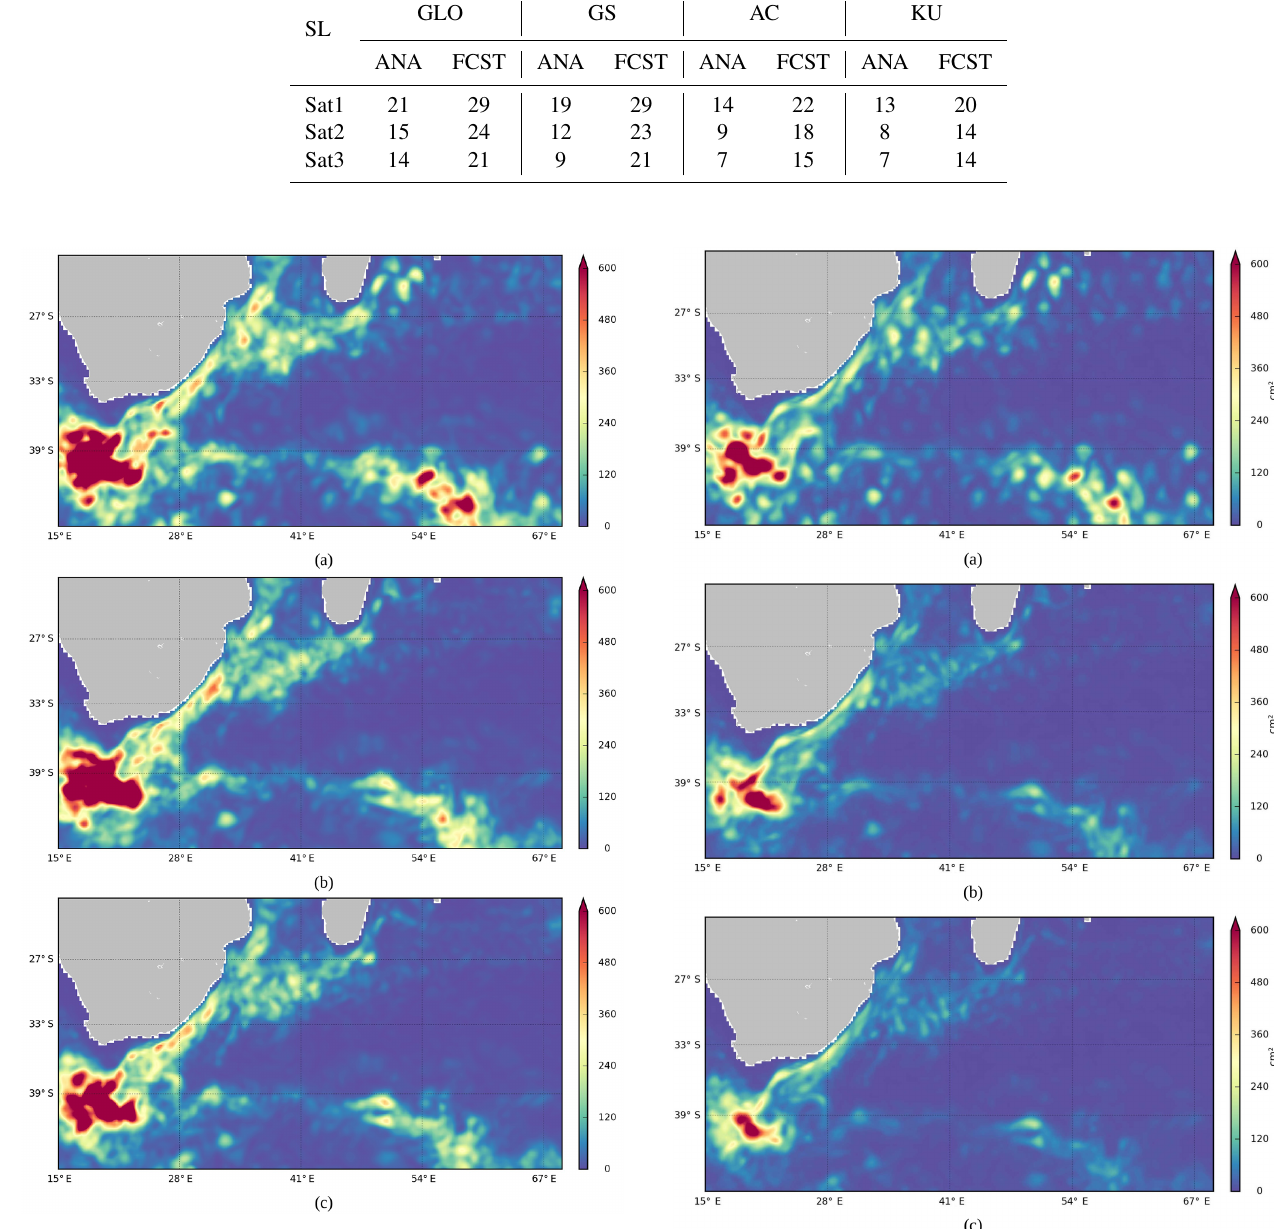
2 for Sat1 (a) , Sat2 (b) and Sat3 (c)